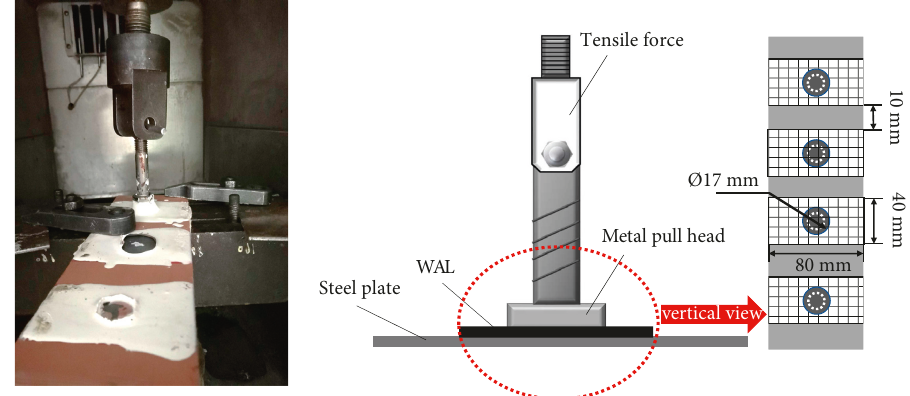
Figure 3: Steel plate-poly(MMA-r-nBA) pull-off